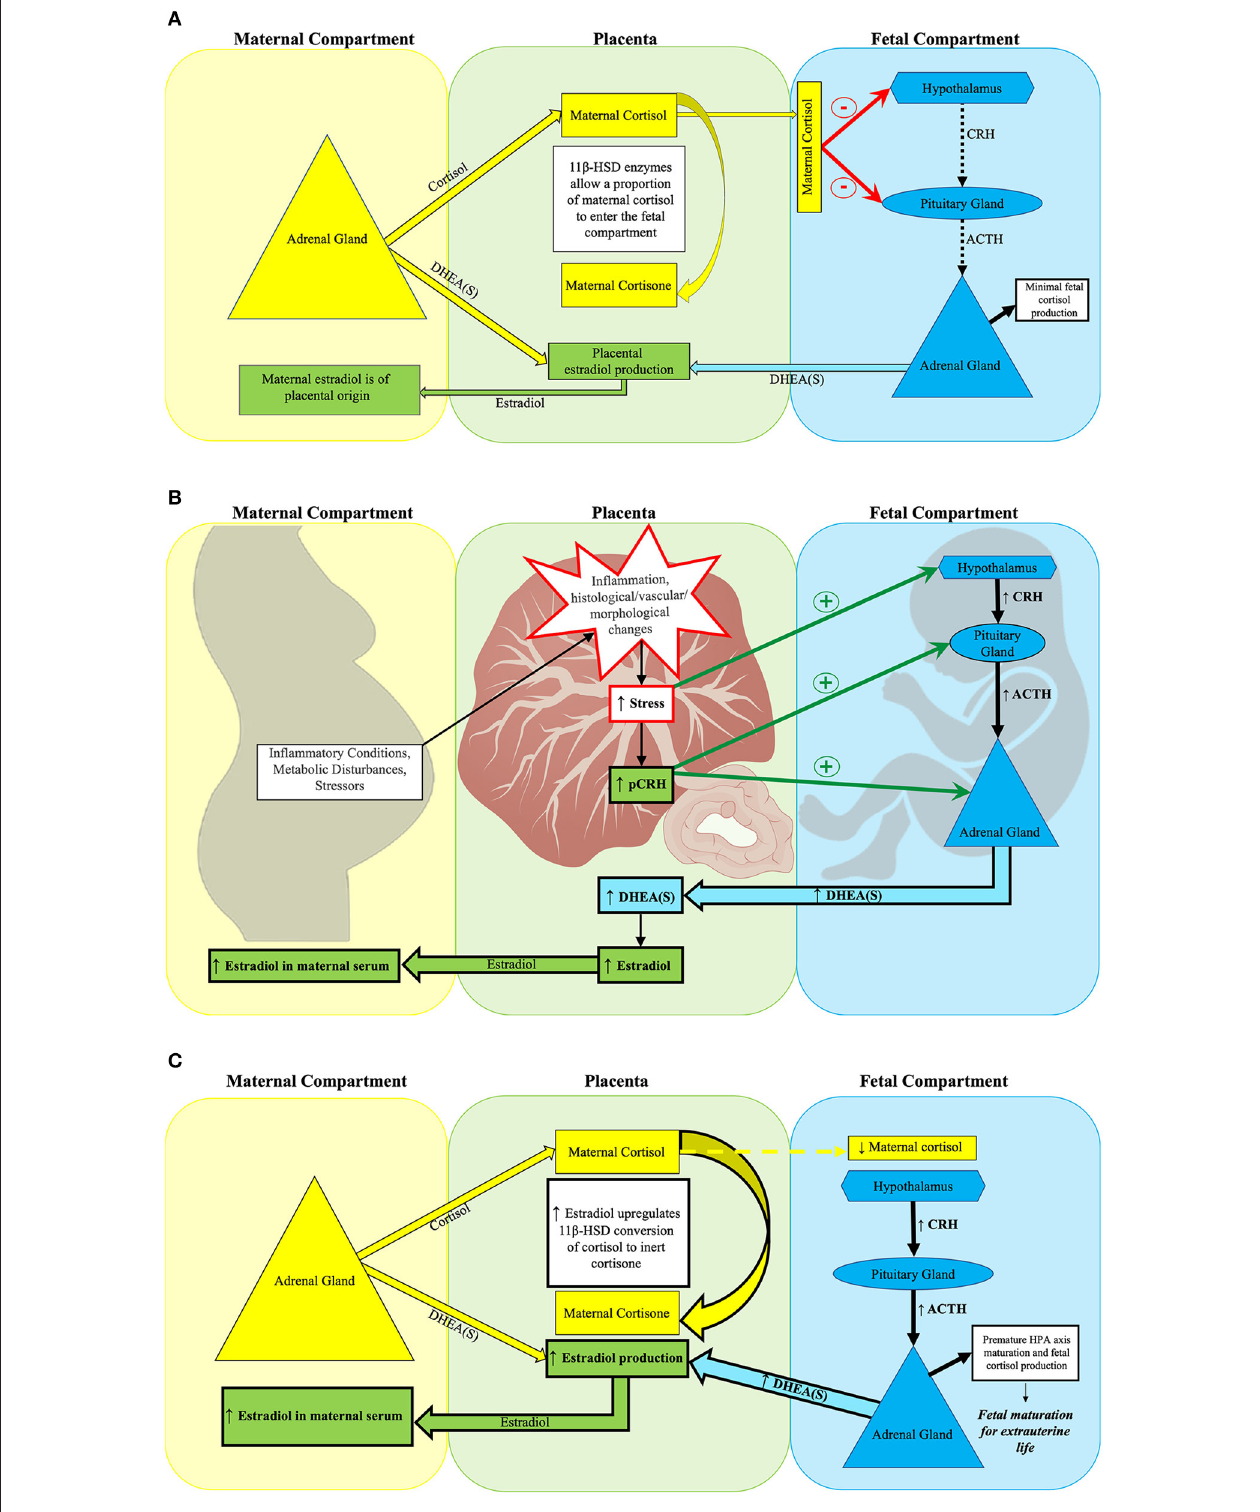
FIGURE 1 | Placental estradiol and the fetal HPA axis at mid-gestation. (A) Normal fetal HPA axis functioning in the setting of typical placental estradiol activity at mid-gestation. (A) Depicts normal suppression of fetal HPA axis activity during mid-gestation by maternal cortisol. The placental glucocorticoid barrier